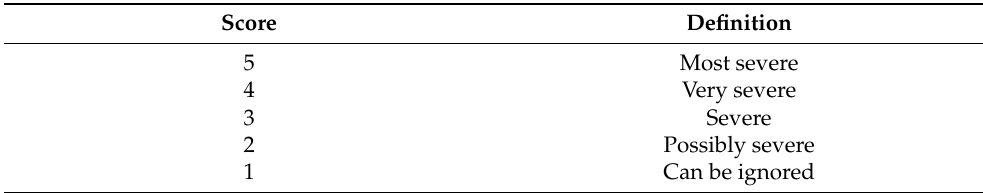
Table A3. Risk severity scoring rules.